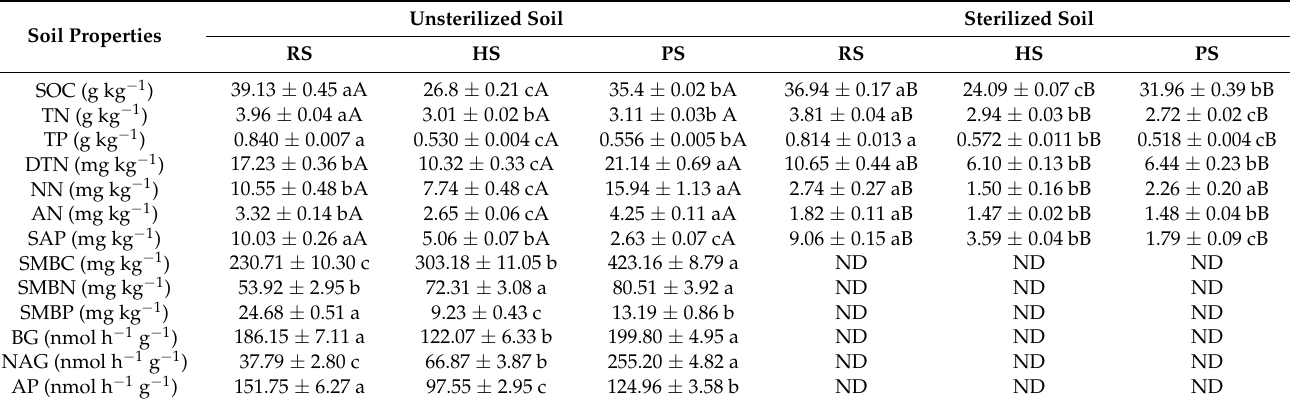
Table 2. Soil properties of the three different unsterilized and sterilized soils after 4 months of R. nepalensis growth (mean ± 1 SE, n =